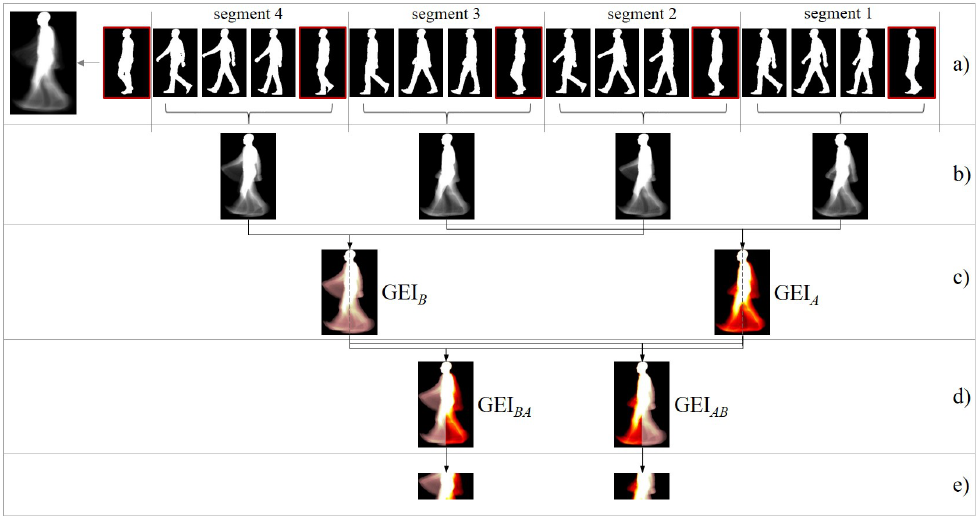
Figure 2. ( a ) A number of key silhouettes representing an r 0.5 -style sequence of 148 silhouettes divided into segments by midstance/midswing poses (framed in red); the GEI of the full sequence is shown on the left. ( b ) Segment-based GEIs. ( c ) Odd and even segment-based GEIs are averaged. ( d ) Two side-dependent GEIs are built. ( e ) ROIs enclosing arm motion are extracted. Subfigures ( c ), ( d ) y ( e ) were drawn with color maps to facilitate